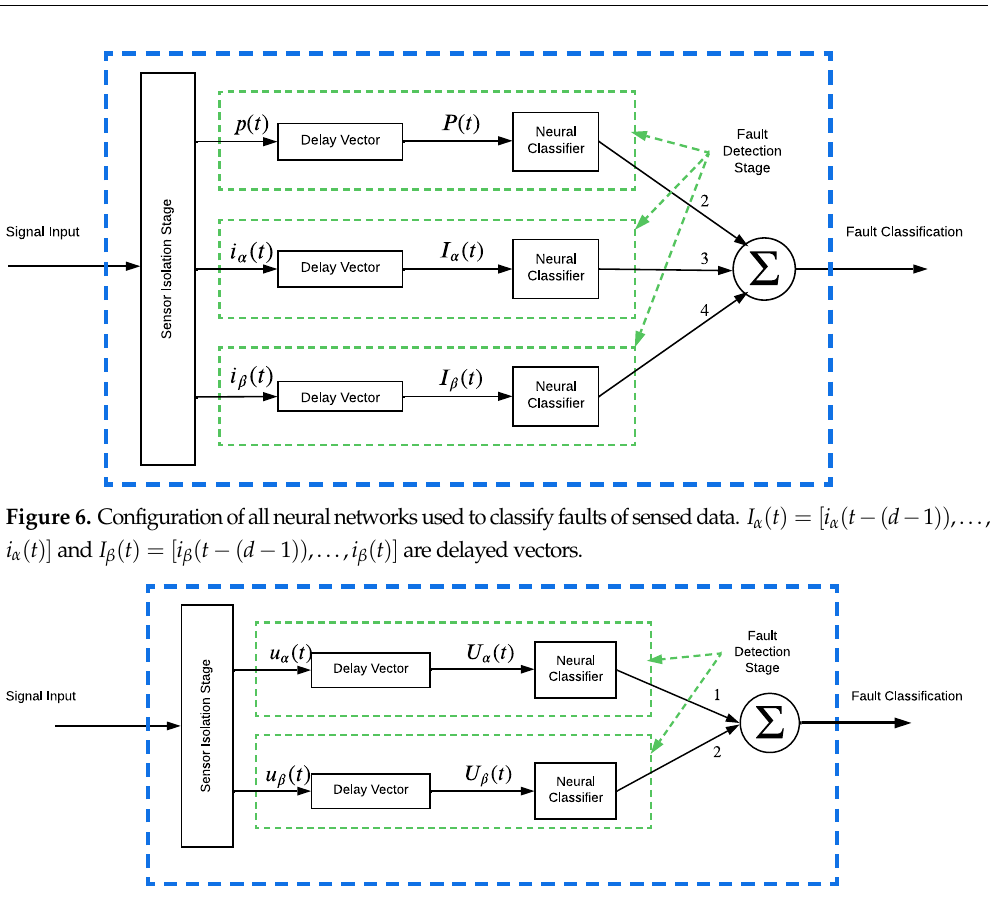
Table 1. Fault labels in sensors.